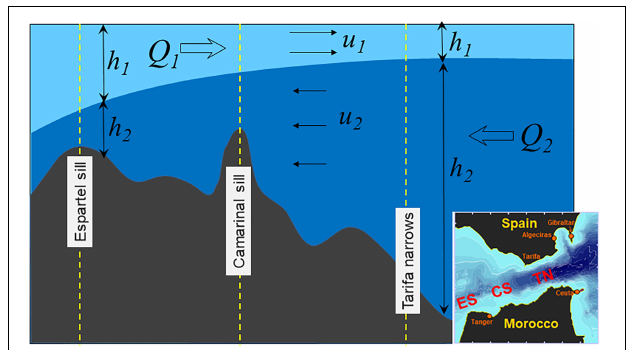
FIGURE 2 | Sketch of the two-layer exchange in the Strait of Gibraltar. Subscripts 1 and 2 stand for variables in the upper and lower layers, whose densities are ρ 1 and ρ 2 , respectively. In a steady state, Q i ’s are constant but u i and h i are not. The three notable topographic sections, Espartel and Camarinal sills and Tarifa narrows, have been indicated in both, the sketch and the inset map. Camarinal sill and Tarifa narrows are the candidate critical sections for steady exchange. In case of time-dependent flow (tides) Espartel sill and Tarifa narrows are much more likely candidates for critical sections (see